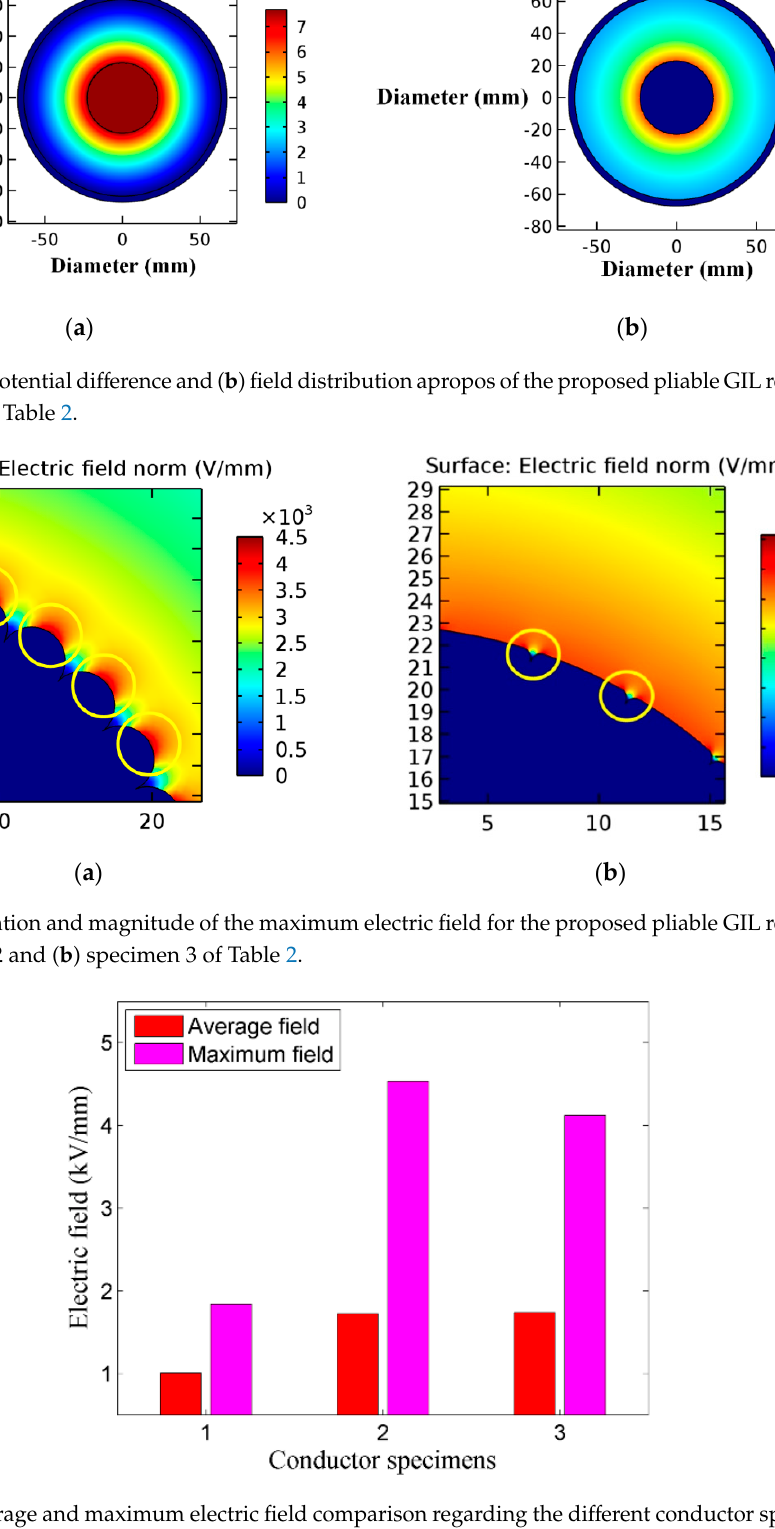
Figure 6. Average and maximum electric field comparison regarding the different conductor specimens described in Table 2.